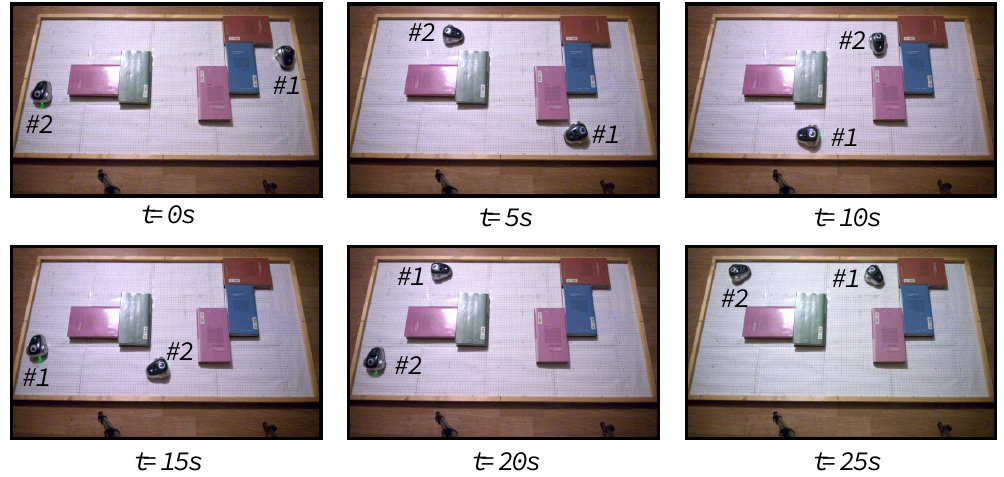
Figure 16. Experiment 2. The obstacle avoidance algorithm using an event-based strategy with a centralized controller and two robots. The symbols #1 and #2 represent Robot 1 and Robot 2,